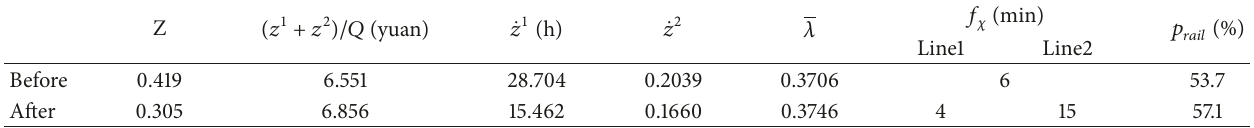
Table 2: The comparison of important values between optimized bus line and the original